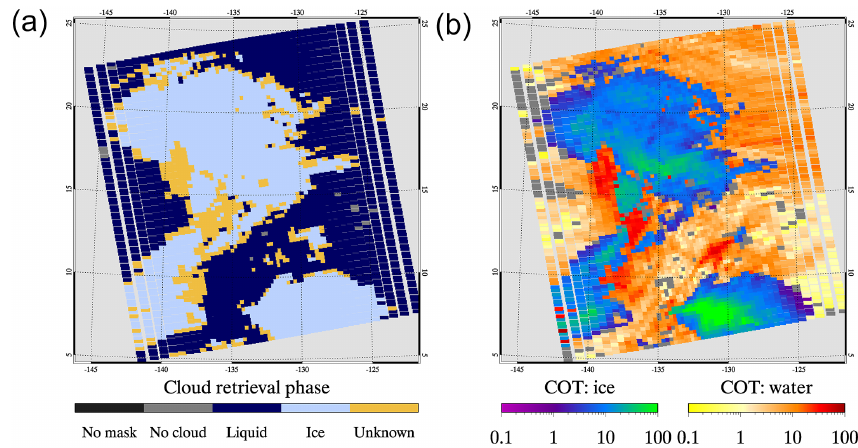
Figure 11. Cloud thermodynamic phase (a) and single-channel COT (b) retrievals corresponding to the Aqua MODIS granule in Figs. 2 and 7. Here, the native 1km (at nadir) MODIS resolution CTT and spectral reflectance are degraded to 25km (at nadir) resolution prior to the retrieval process.